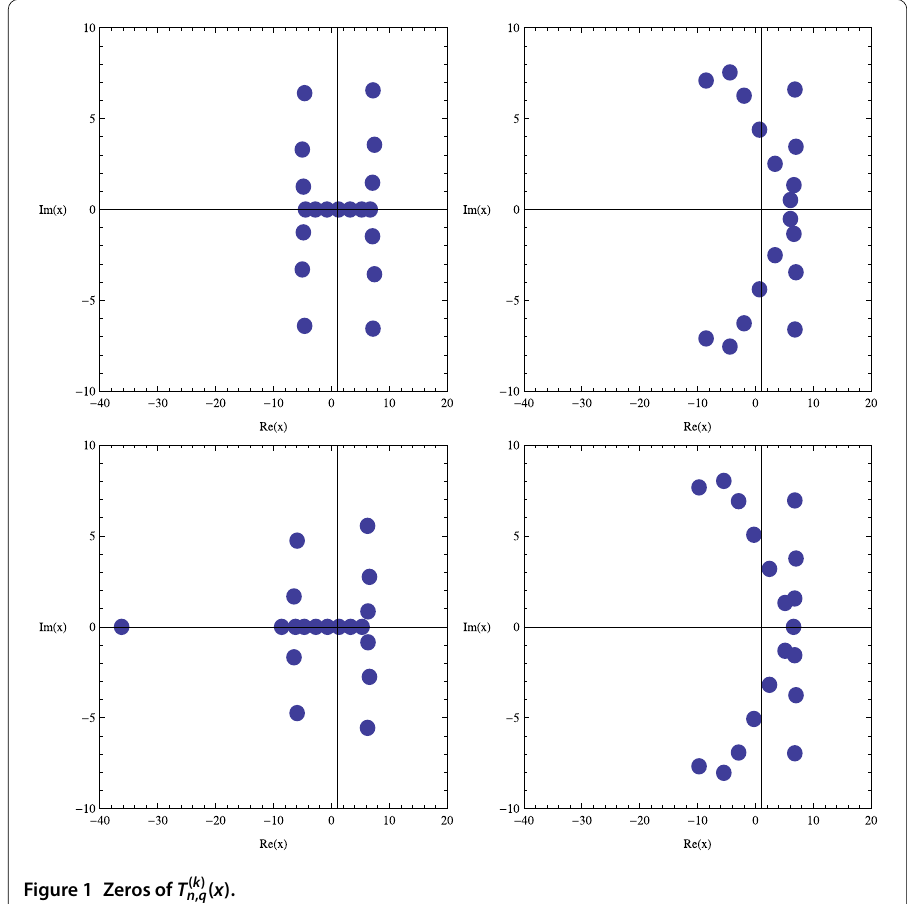
Figure 1 Zeros of T ( k ) n , q ( x